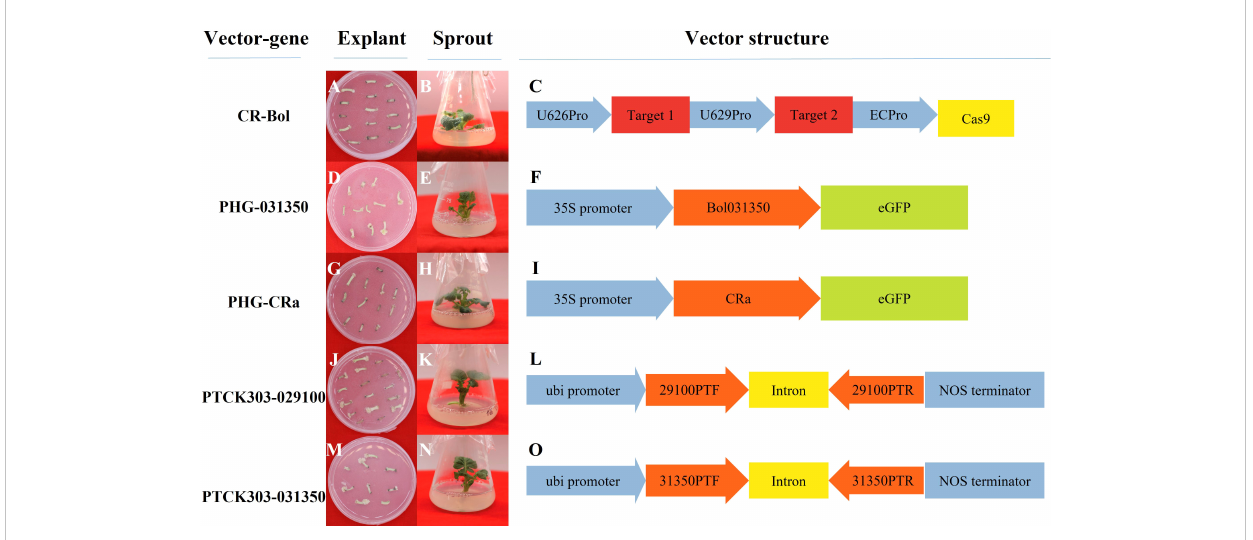
FIGURE 2 Pro fi les of the vector performance in 19B42 and their structural differences. (A-C) Hypocotyls and sprouts from19B42 with vector CR- Bol accompanied, and the structure of vector CR- Bol . (D-F) Hypocotyls and sprouts from19B42 with vector PHG- 031350 accompanied, and the structure of vector PHG- 031350 . (G-I) Hypocotyls and sprouts from19B42 with vector PHG- CRa accompanied,and the structure of vector PHG- CRa . (J-L) Hypocotyls and sprouts from19B42 with vector PTCK303- 029100 accompanied,and the structure of vector PTCK303- 029100 . (M-O) Hypocotyls and sprouts from19B42 with vector PTCK303- 031350 accompanied,and the structure of vector PTCK303- 031350